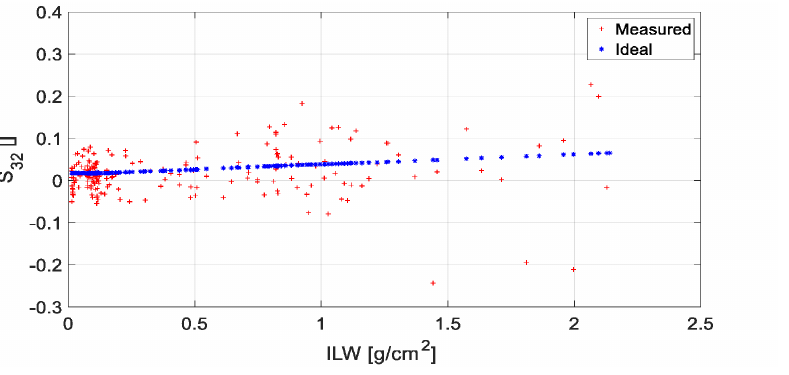
Figure 11. Scatter plots between ILW and S 32 for all tangent altitudes in ideal (no impairments) and true propagation conditions.